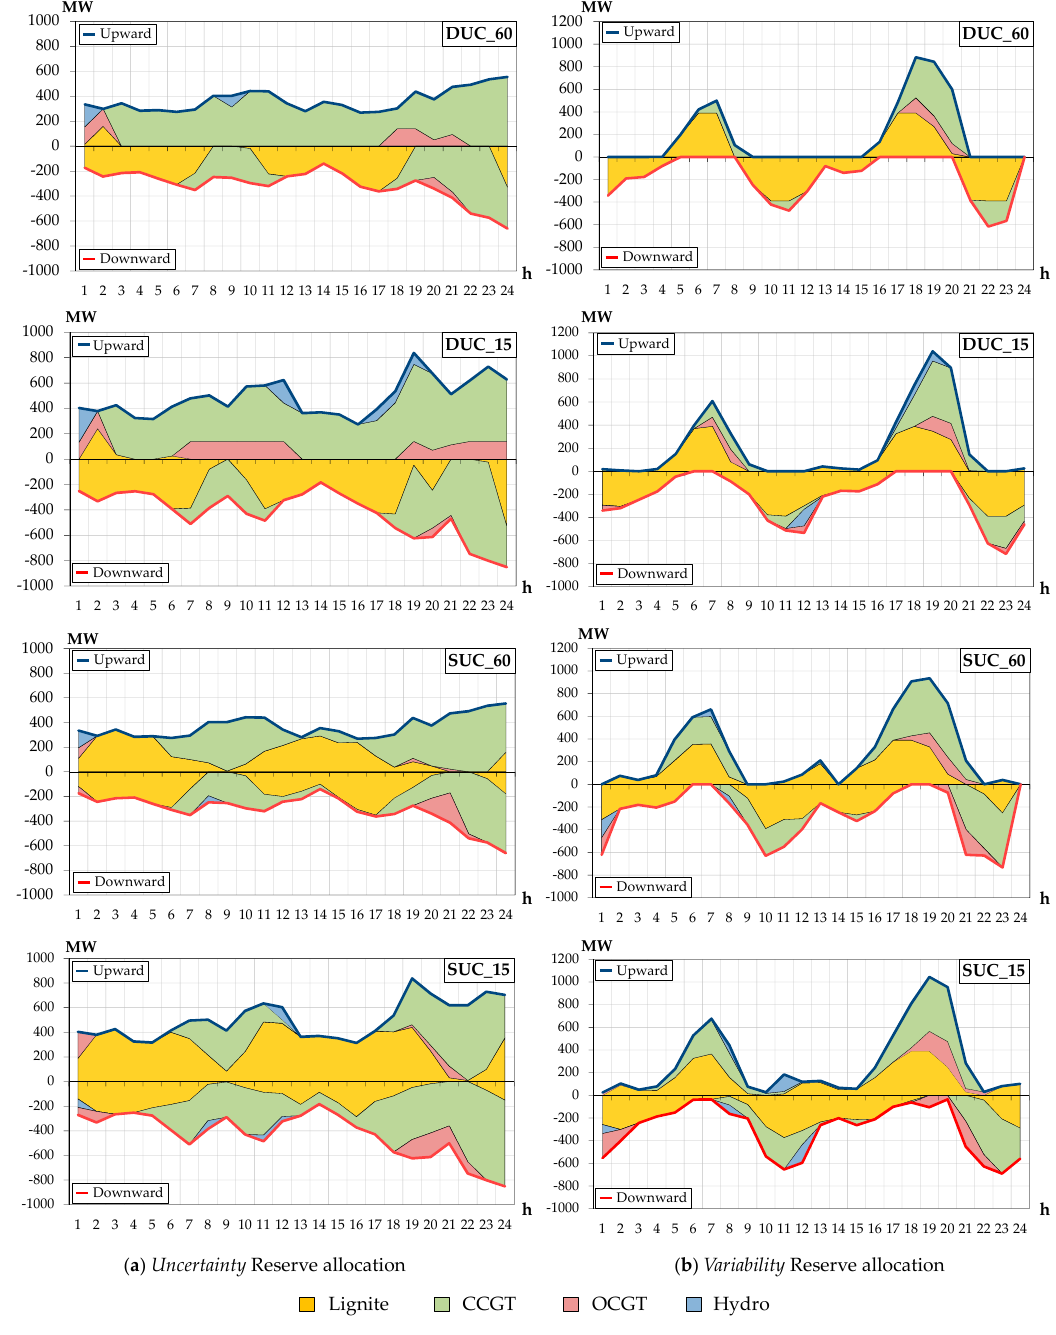
Figure 3. Uncertainty and variability reserve allocation per unit category in various UC policies.